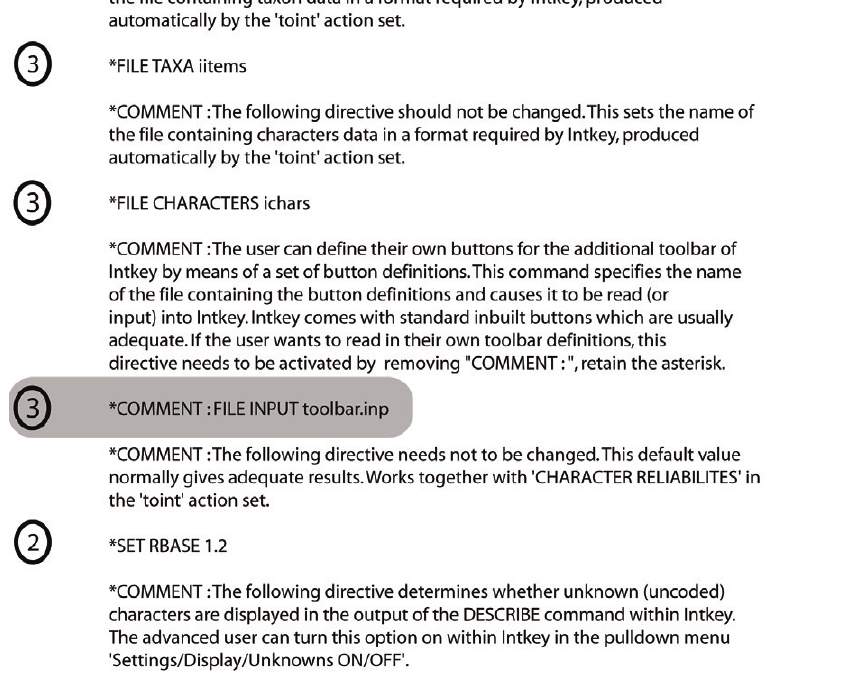
Figure 35. Th e Intkey.ink directive fi le specifi es the Intkey data fi les and makes settings in Intkey at the beginning of each session. Th e numbers to the left of the directive fi le indicate diff erent classes of directives (see in Table 8). Th e grey ovals show commands where input of the user might be required. (continued on next